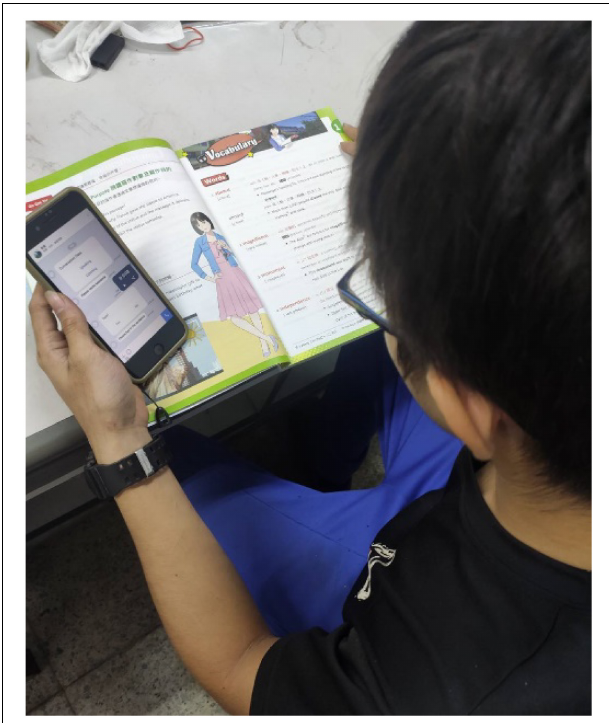
FIGURE 2 | English conversational exercise with speaking and listening in the LINE ChatBot.